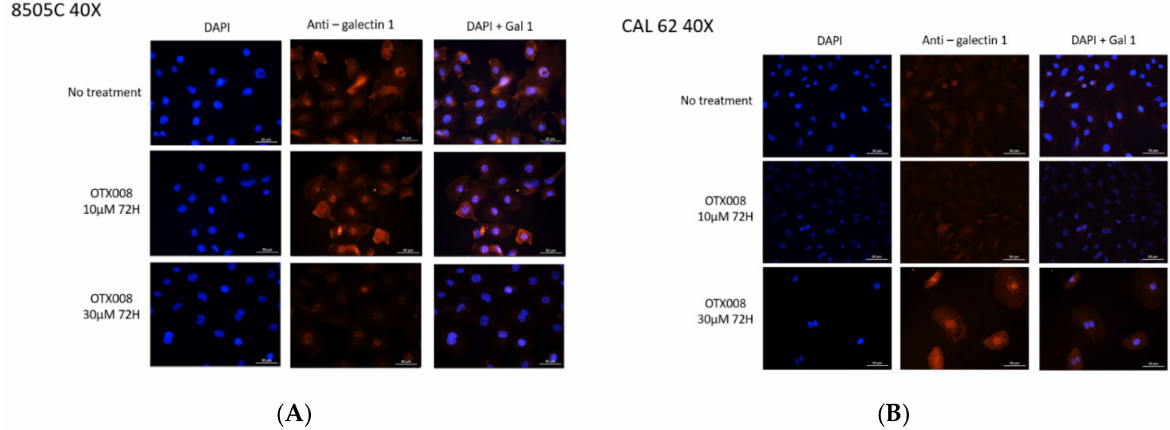
Figure 7. Immunofluorescence analyses using confocal analysis showing the expression of galectin-1 in anaplastic cell lines exposed to OTX008. Cell treatment with OTX008 affected cytoplasmic and nuclear localization in ( A ) 8505c cells and ( B ) CAL 62